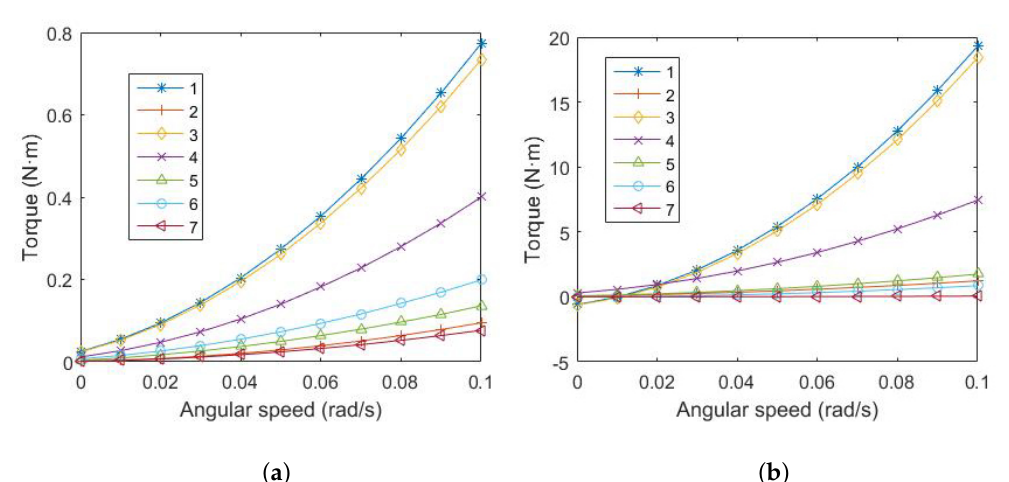
Figure 10. Deviation of simulated and space joints: ( a ) deviation after mass-matching; ( b ) deviation without counterweight.